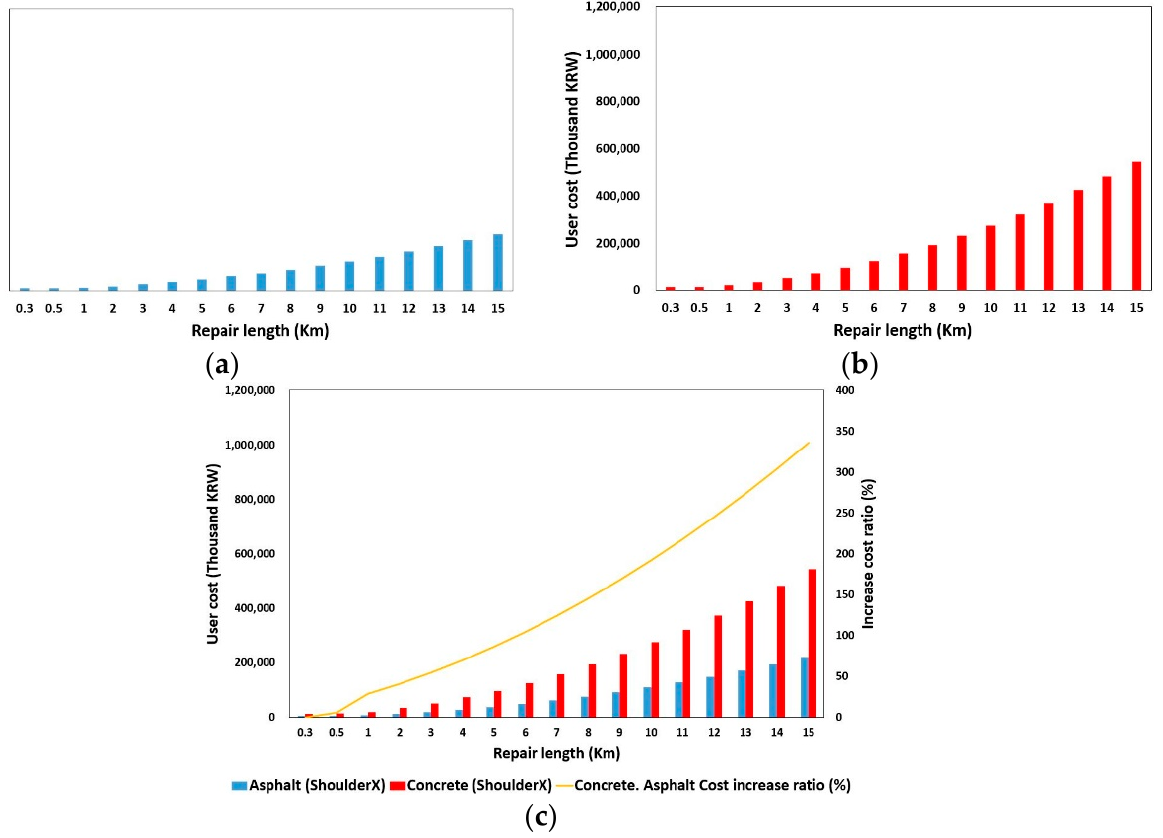
Figure 2. User cost comparison (Shoulder X, 6000 AADT). ( a ) Asphalt overlay user cost (Shoulder X). ( b ) Concrete overlay user cost (Shoulder X). ( c ) Comparison of overlay user cost (Shoulder X).